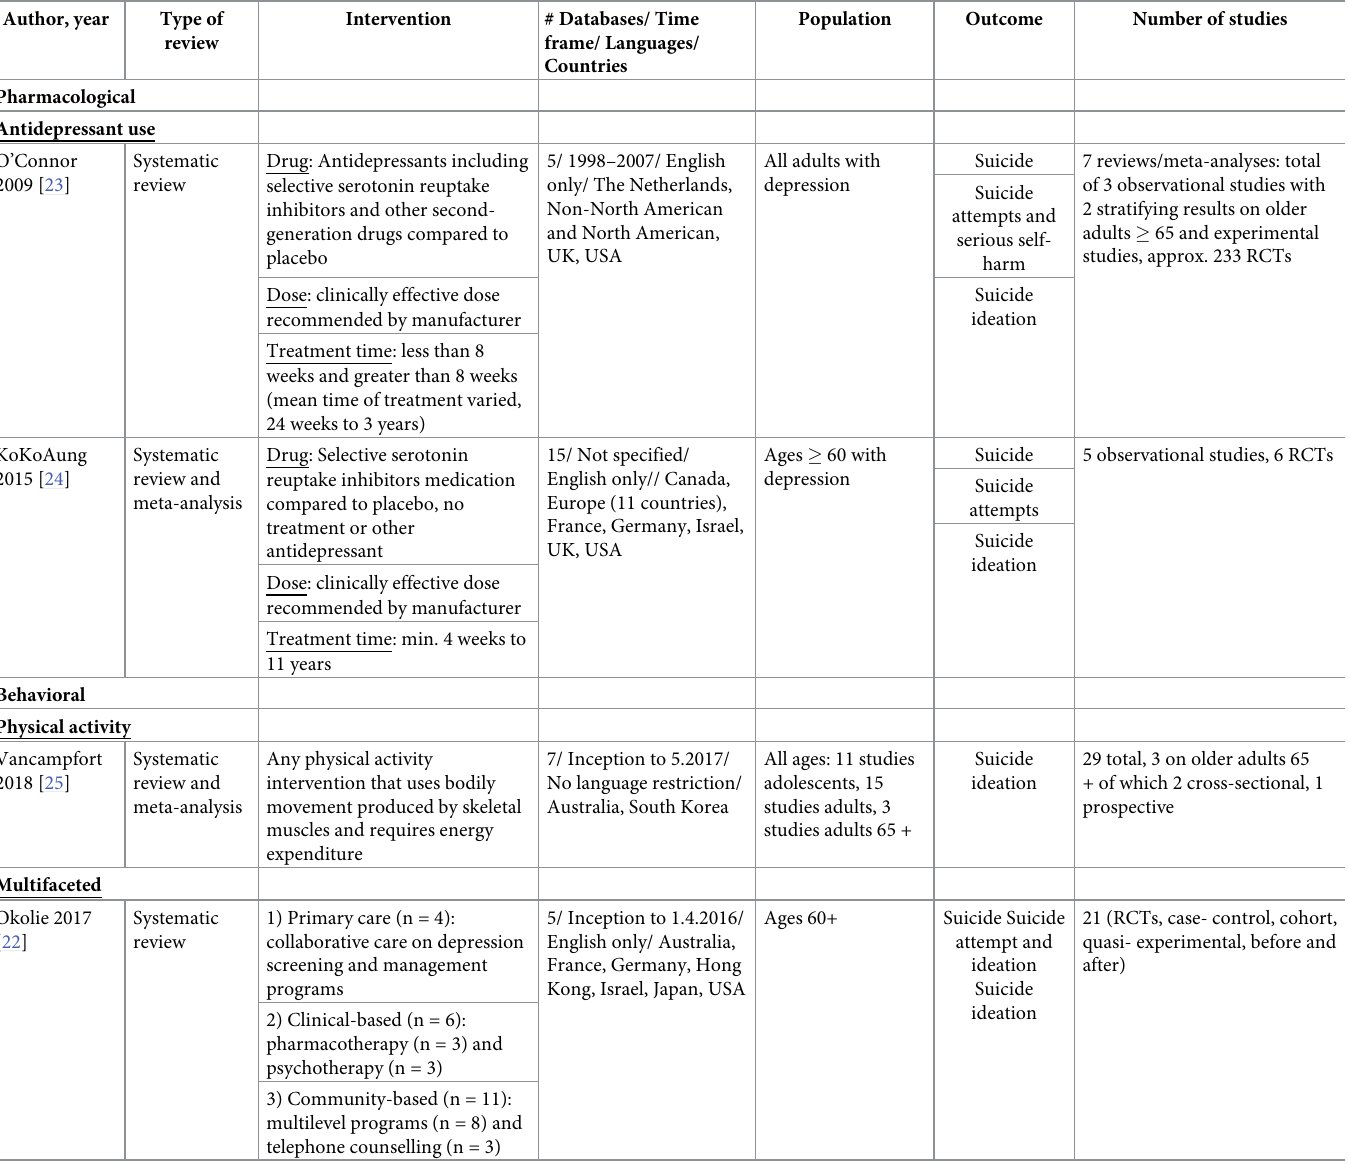
Table 2. Characteristics of four included